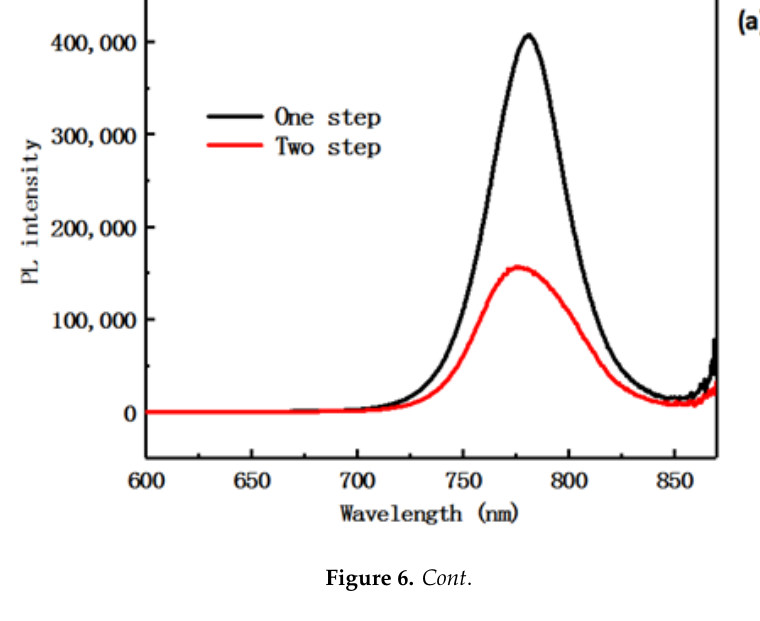
Figure 6. Cont Figure 6. Photoluminescence (PL) spectra of perovskite films with the one-step process method ( a ) and the two-step process method ( b ).